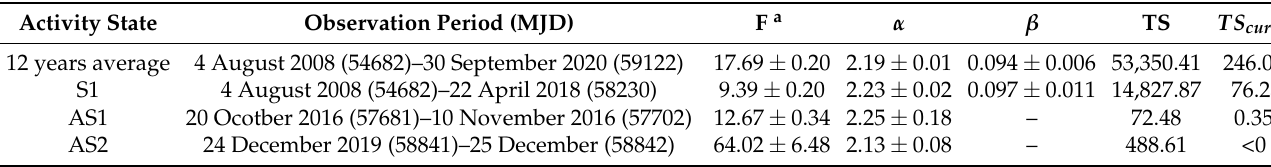
Table 2. Fermi -LAT analysis for different activity